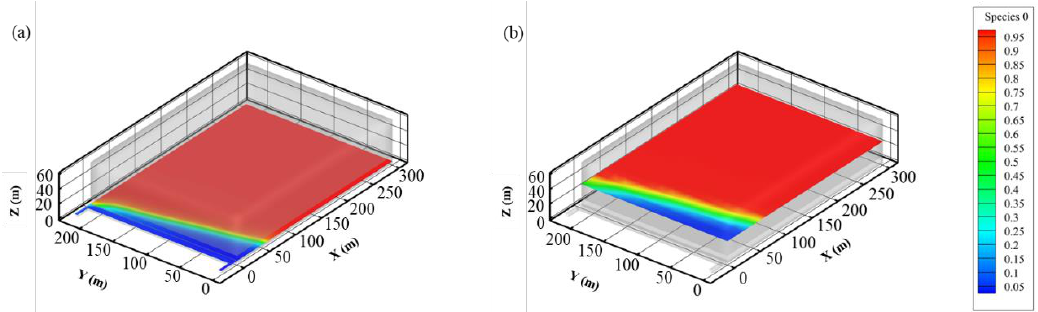
Figure 4. Characteristics of layered gas migration and accumulation of ( a ) caving zone and ( b ) fracture zone.